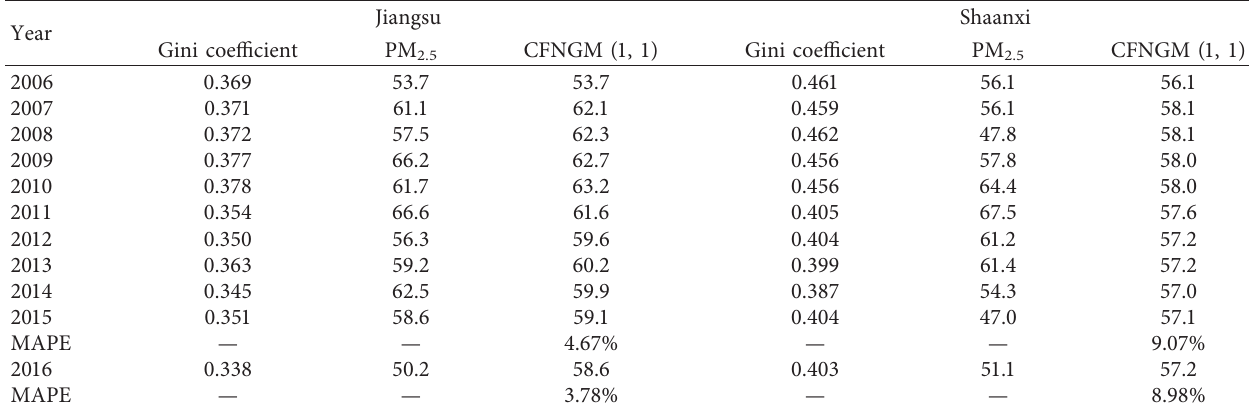
Table 2: The result of the CFNGM (1, 1) model in two